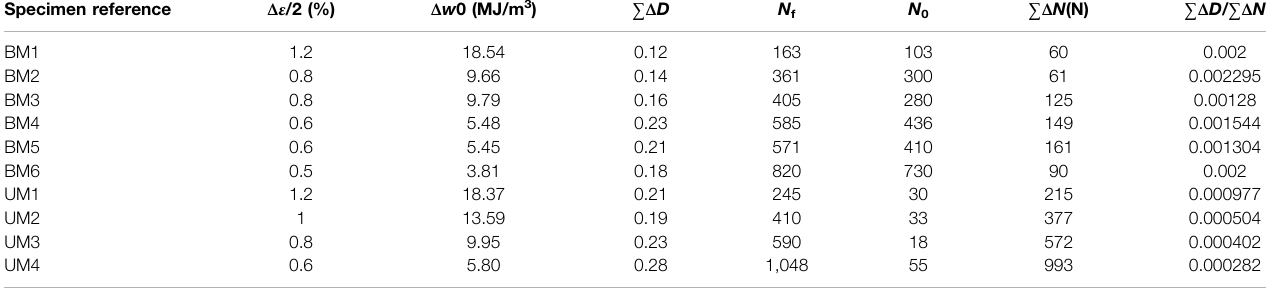
TABLE 4 | Fatigue damage values under each cycle from the experimental data. Specimen reference